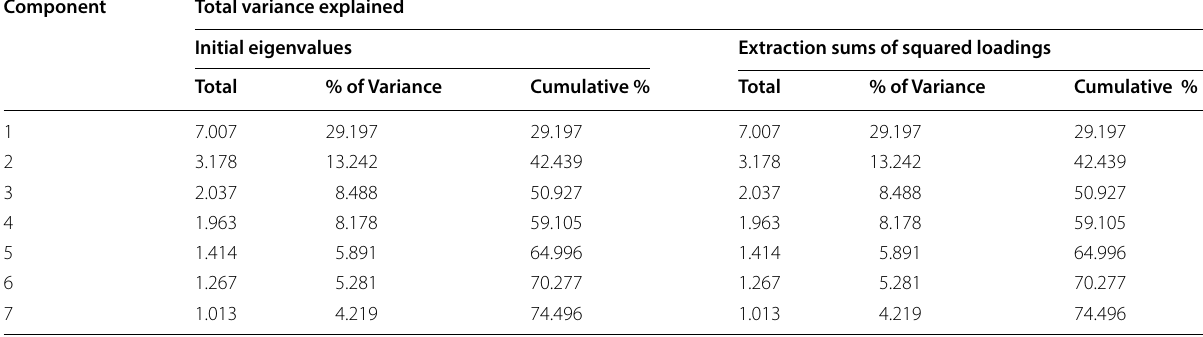
Table 2 Principal component analysis